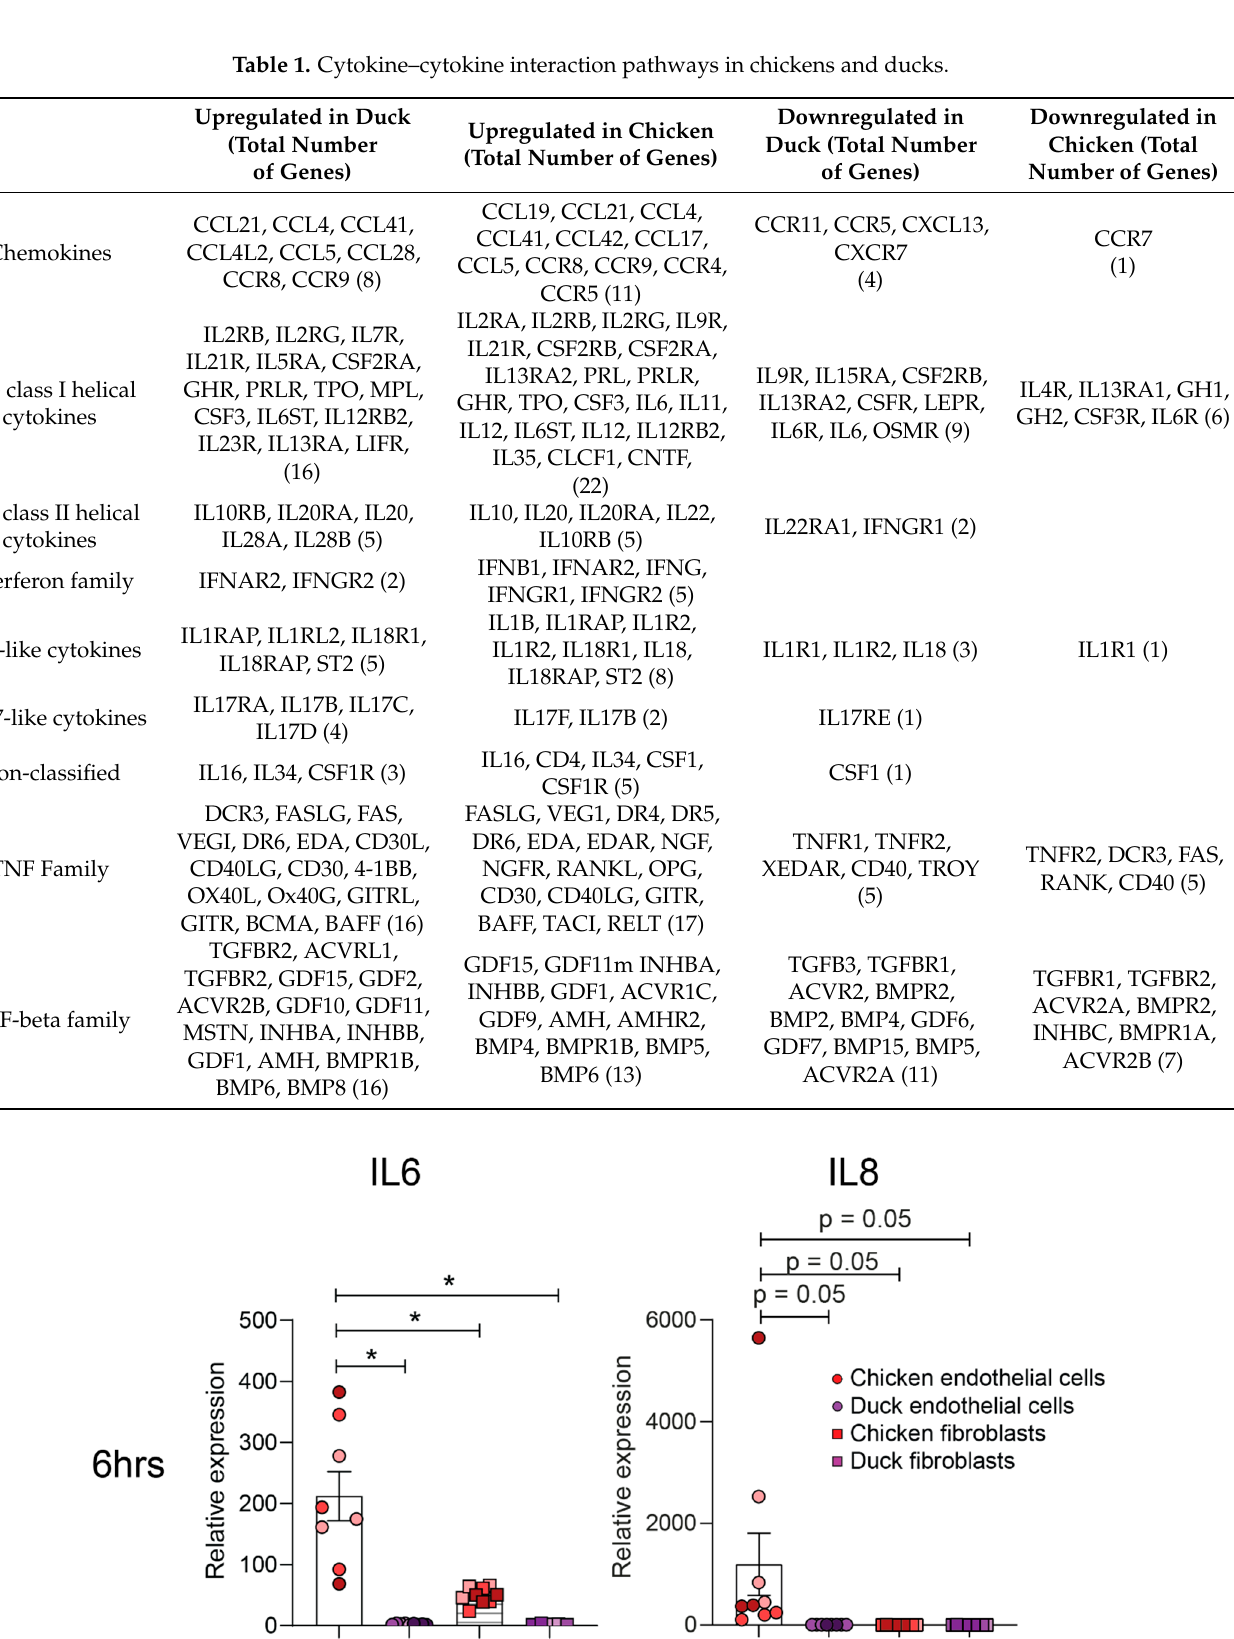
Figure 3. Cytokine response to polyI:C treatment in chicken and duck endothelial cells and fibroblasts. Avian endothelial and fibroblast cells were treated with either PBS or PBS containing 25 µg/mL PolyI:C (Sigma Aldrich). IL-6 and IL-8 gene expression were used as representatives for pro-inflammatory cytokine production and were analysed using the RT-qPCR analysis at different timepoints. Data are pooled ( n = 9) from three independent experiments with experimental replicates shown in the same colour. Statistical significance is represented by asterisks (* = p < 0.05) Results are means ± SEM.